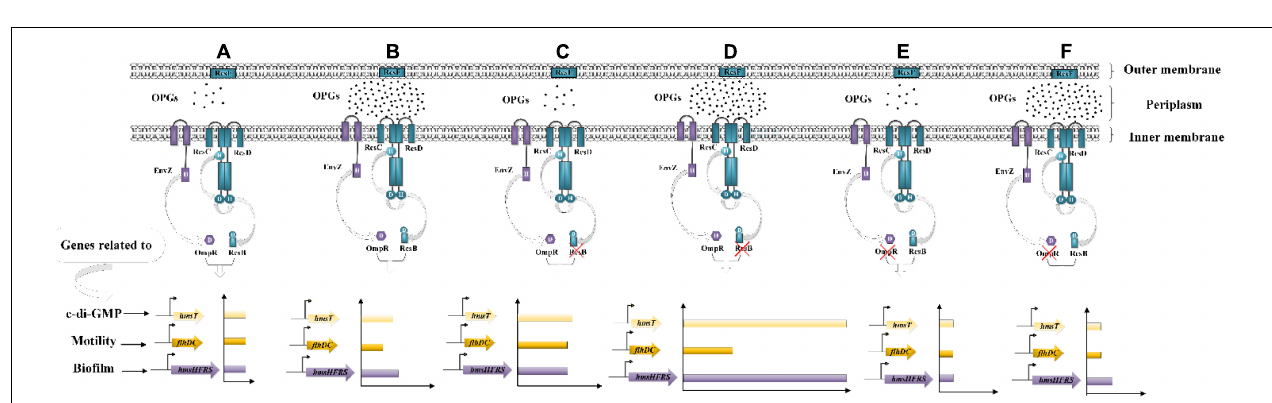
FIGURE 8 | Working model of the relationship between OPGs and the Rcs phosphorelay in Y. enterocolitica . (A) In the wild-type strain, the Rcs system represses cell motility, division and biofilm formation by inhibiting flhDC , ftsAZ, and hmsHFRS expression. (B) OPGs deficiency activates the Rcs phosphorelay and inhibits flhDC, ftsAZ, and hmsHFRS expression, resulting in further repression of cell motility, division, and biofilm formation. (C–E) Disruption of the Rcs phosphorelay pathway downregulates RcsB phosphorylation, restoring cell motility, division, and biofilm formation by enhancing the expression of flhDC , ftsAZ, and hmsHFRS .